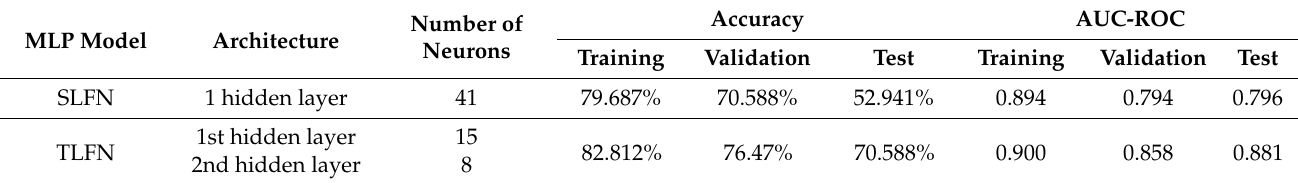
Table 3. The performance measures of the best SLFN and TLFN